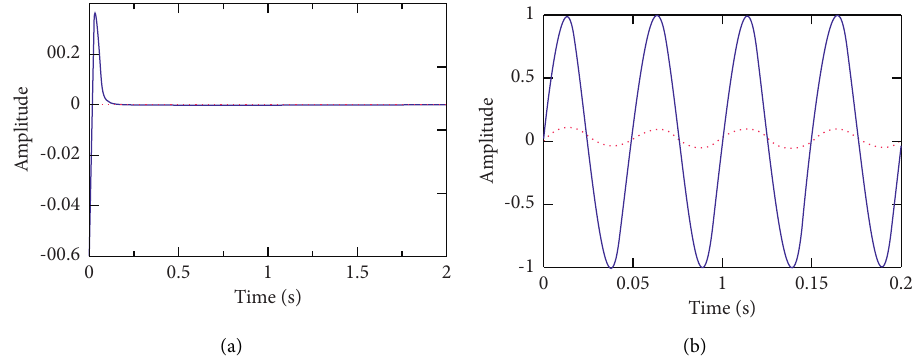
Figure 7: Response curve of e a to T h . (a) Unit step and (b) sine wave (20Hz).